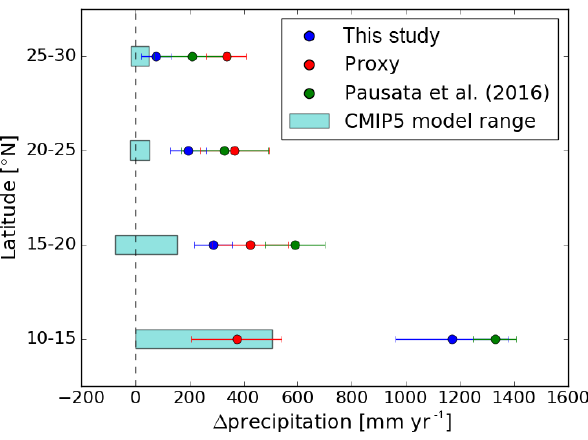
Figure 3. Comparison of reconstructed and simulated precipita- tion changes between the mid-Holocene and the preindustrial era. The simulated zonal mean (17 ◦ W–40 ◦ E) anomalies between mid- Holocene and preindustrial precipitation from this study are aver- aged over 5 ◦ latitudinal bands between 10 and 30 ◦ N at the location of grid cells for which reconstructions are available. Proxy data are from a reconstruction of precipitation from (Bartlein, 2011). Fur- ther, the CMIP5 model range (Harrison et al., 2015) and model val- ues from (Pausata et al., 2016) are averaged for the grid cells for which reconstructions are available. Temporal standard deviations are given for our study and for (Pausata et al., 2016), and spatial variation is indicated for the proxy data.